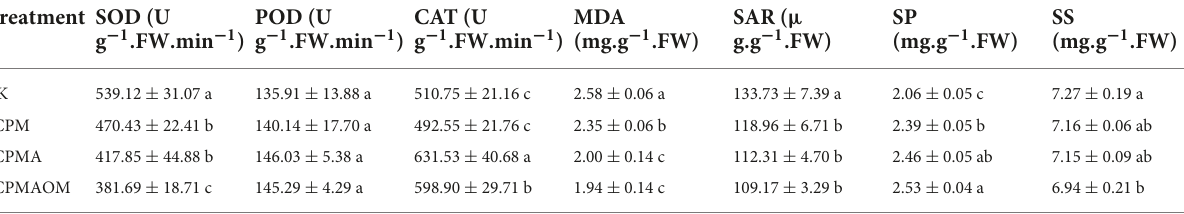
TABLE 2 Superoxide dismutase (SOD), POD, CAT activities and MDA, SAR, SP, and SS levels in C. tangshen leaves in different